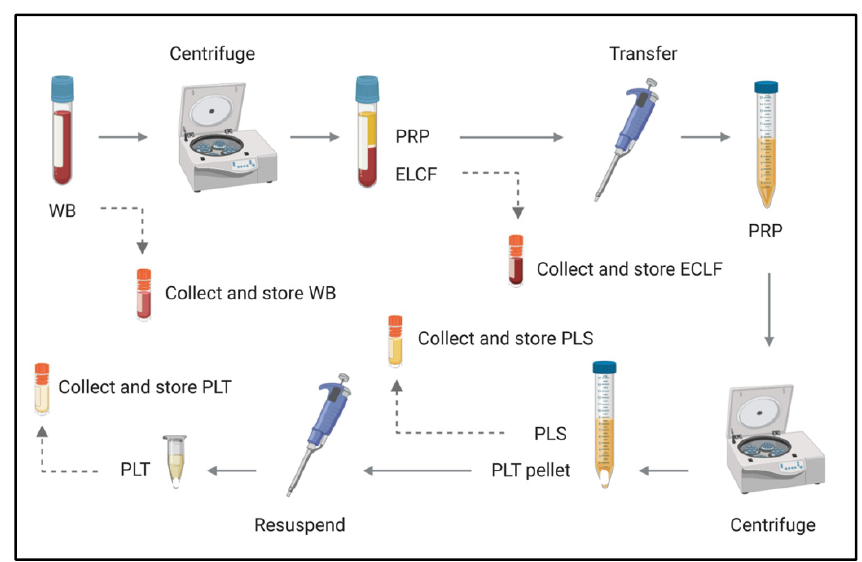
Figure 4. Schematic of blood fractionation protocol. Multiple steps were implemented to obtain a panel of blood components for comparison by microscopy, culture and molecular analyses. The initial centrifugation step pellets red and white blood cells at 120× g for 20 min, leaving a platelet-rich plasma supernatant which is subsequently spun at 400× g for 20 min to obtain platelets (pellet) and acellular plasma (supernatant). WB = whole blood, ELCF = erythrocyte, leukocyte cellular fraction, PRP = platelet-rich plasma, PLS = plasma (platelet poor), and PLT = platelet fraction.